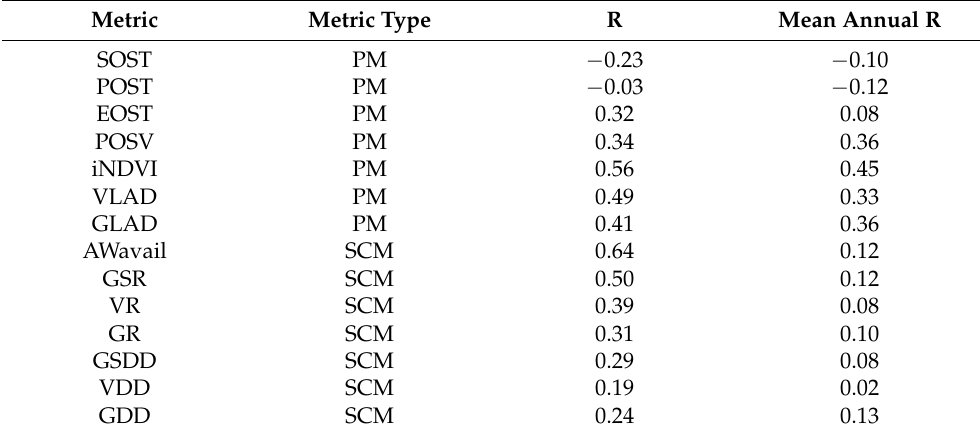
Table 3. Overall and annual relationships between phenological (PM) and seasonal climate metrics (SCM) and